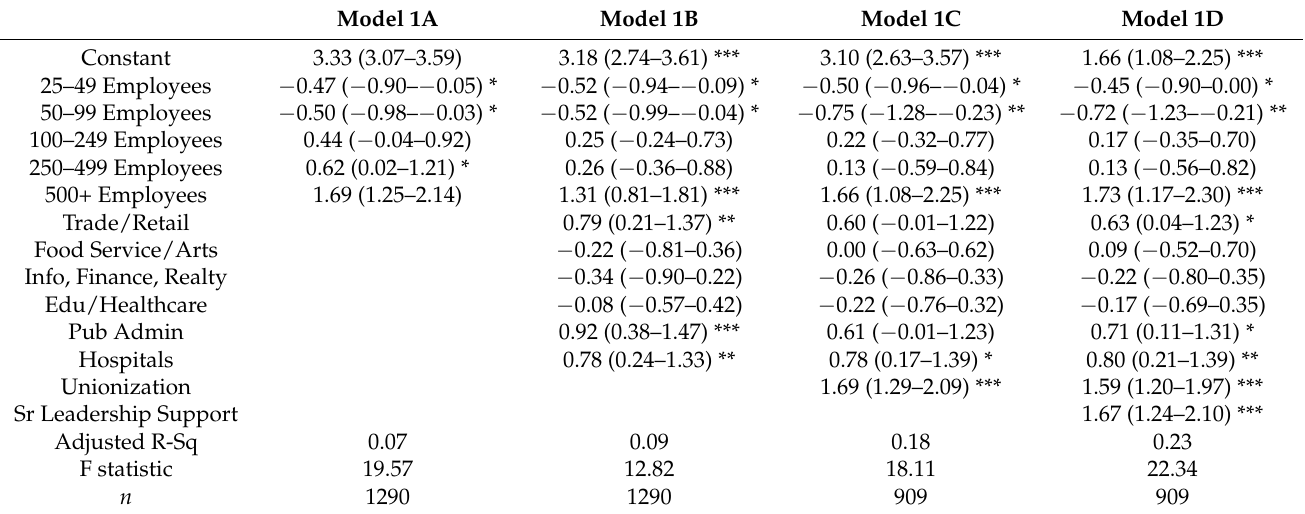
Table 3. Ordinary least square based on number of programs with unstandardized coefficients